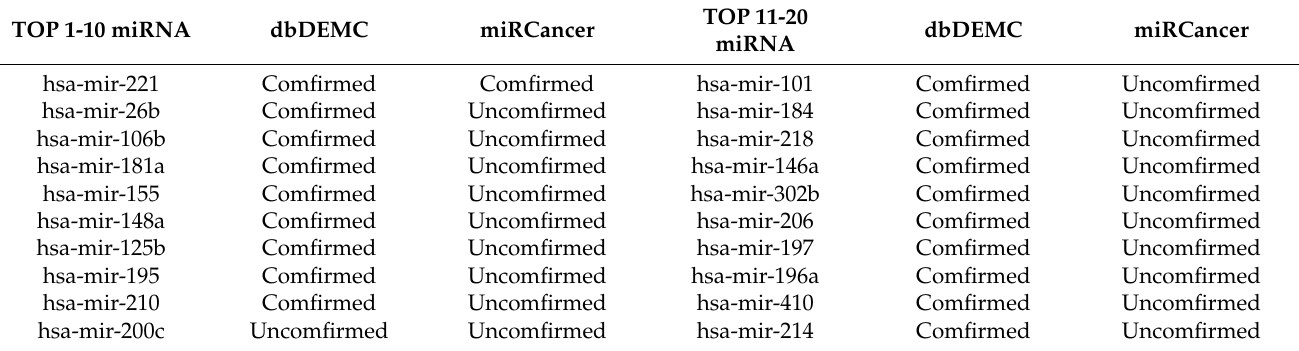
Table 5. Top 20 brain neoplasm-related miRNAs predicted by SGAEMDA based on HMDD v2.0.